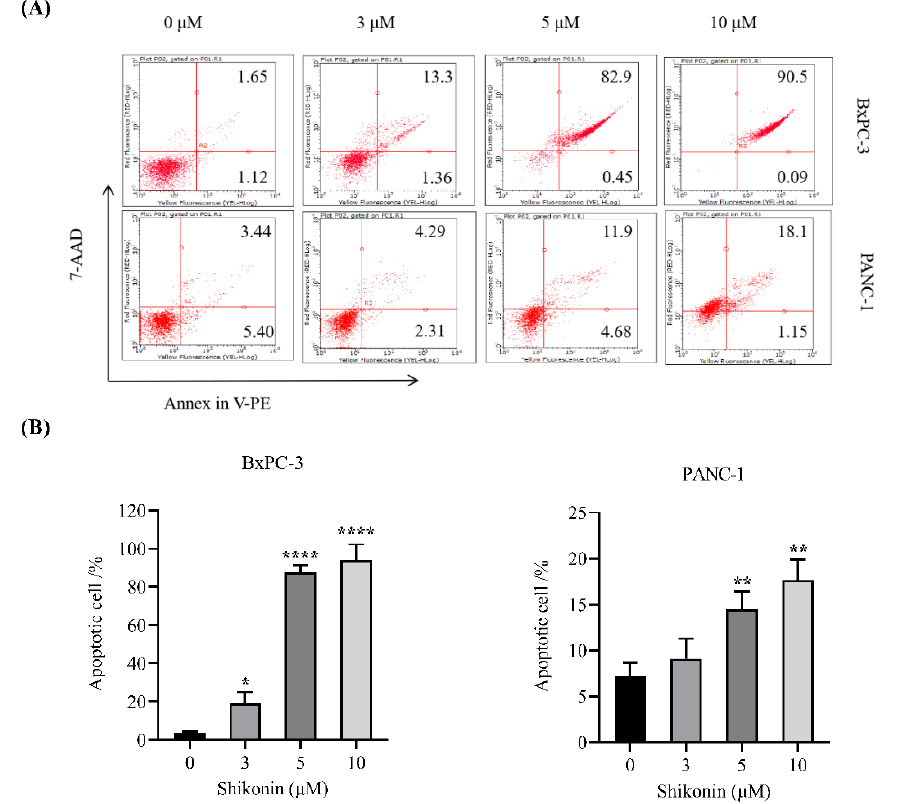
Figure 5. Shikonin induced apoptosis of pancreatic cancer cells. ( A ) BxPC − 3 and PANC − 1 cells were treated with shikonin for 24 h, and apoptosis was detected using Annexin V/7 − AAD staining and flow cytometry. ( B ) Quantification of apoptotic cells. Results are means ± SD of three